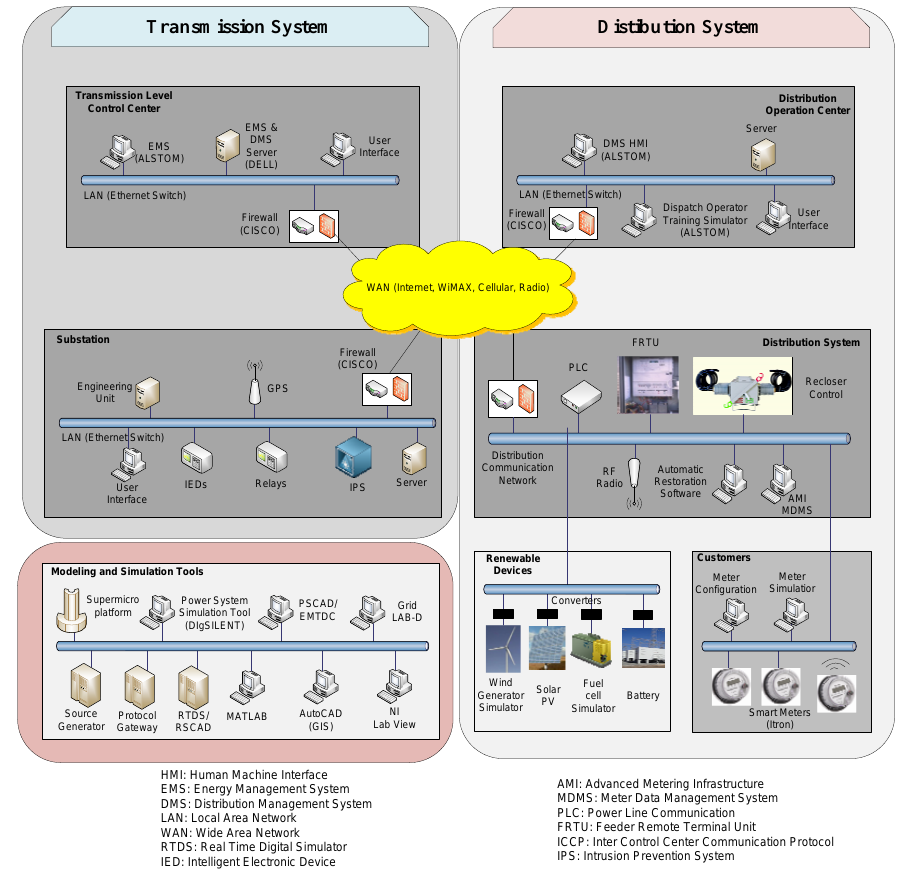
Figure 5. SCT at WSU.